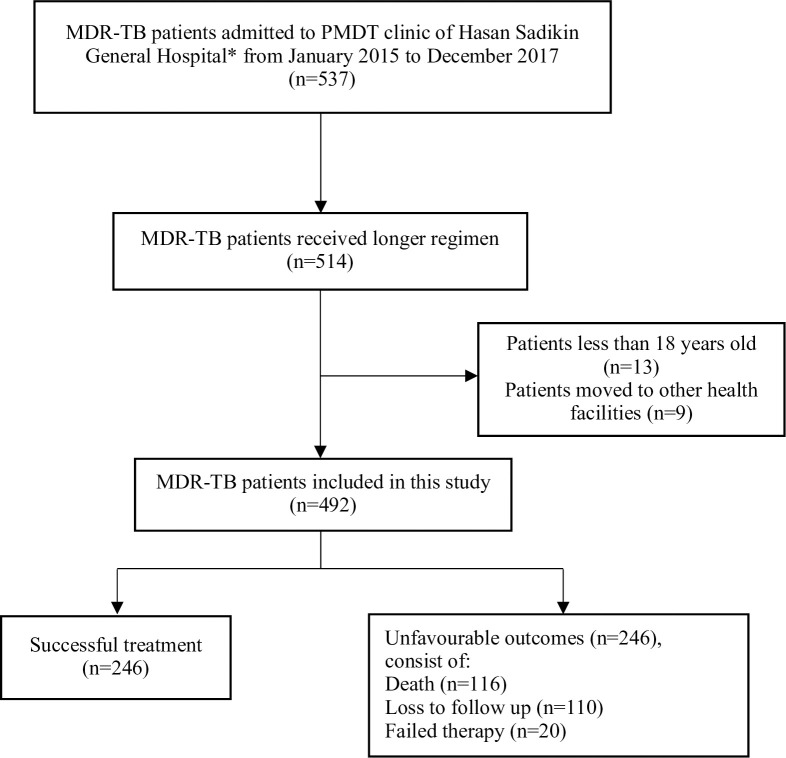
Flow chart of study participants.MDR-TB: Multidrug-resistant TB, PMDT: Programmatic Management of Drug-resistant TB. * Tertiary referral hospital that provides treatment for drug-resistant TB patients.